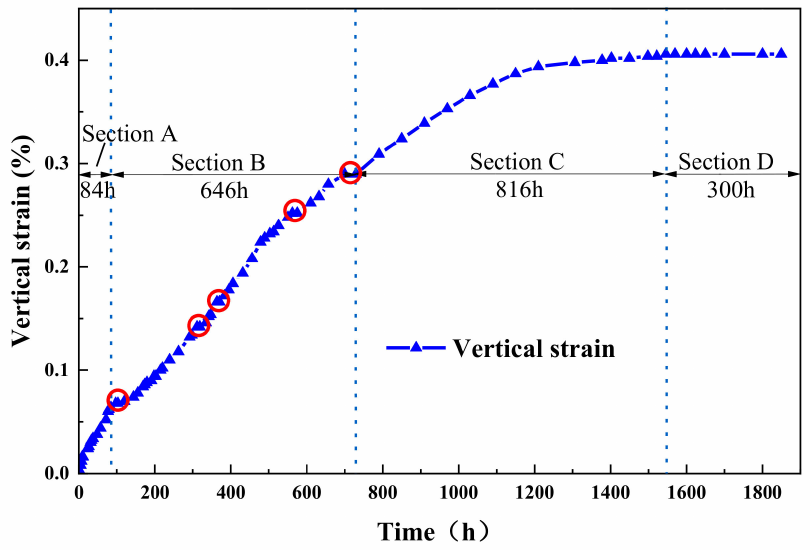
Figure 4. Swelling rate curve with